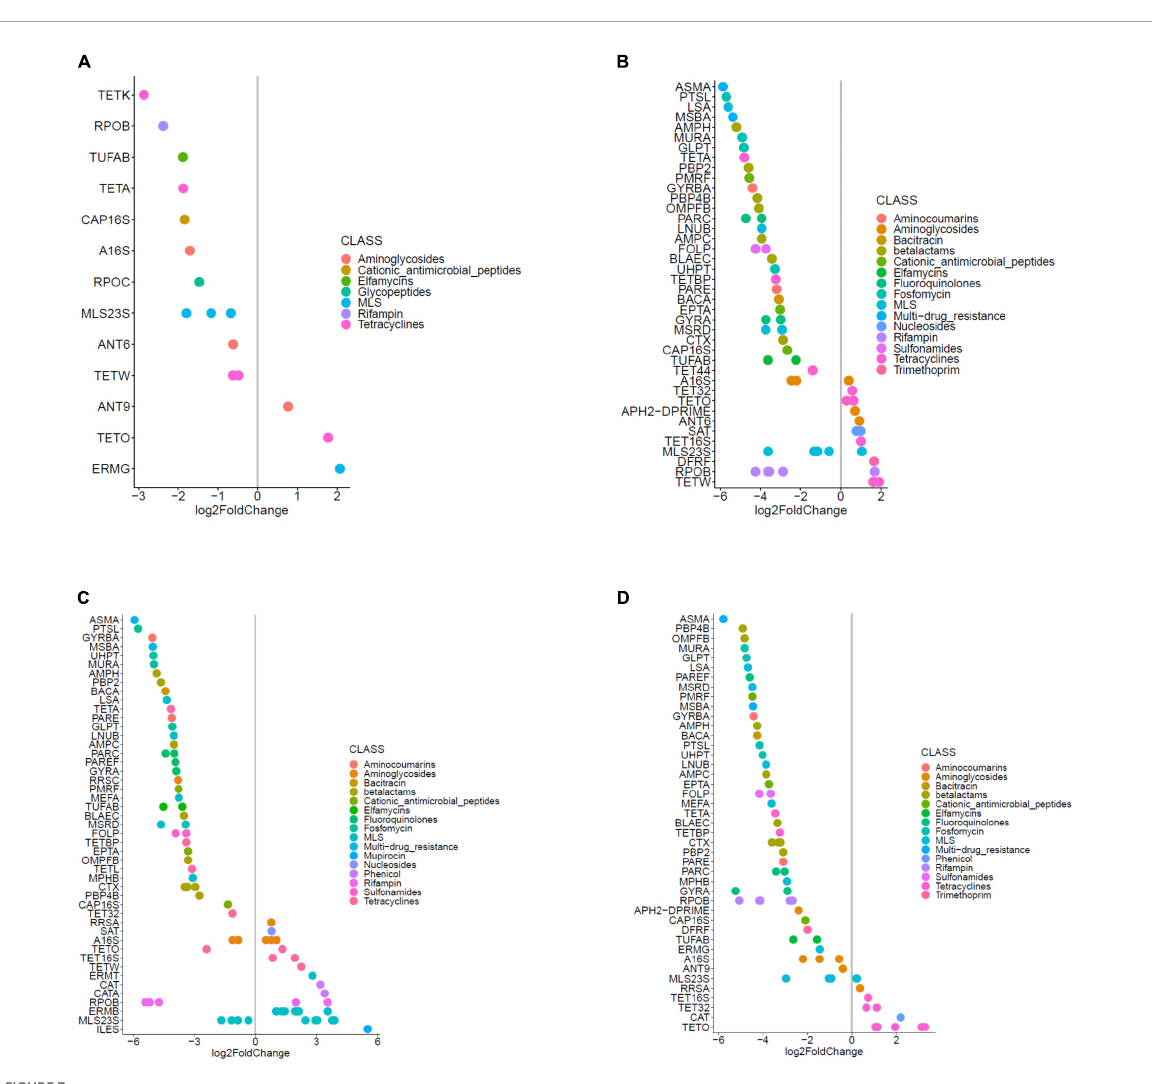
FIGURE7 Significant ( q < 0.10) log-fold changes in the abundances of ARG hits in (A) samples from OPT_PS taken at day 20, (B) samples from High group taken at day 24, (C) samples from OPT group taken at day 24, and (D) samples from OPT_PS group taken at day